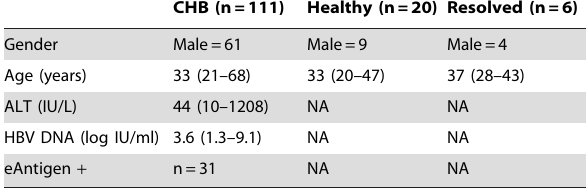
Table 1. Patient clinical